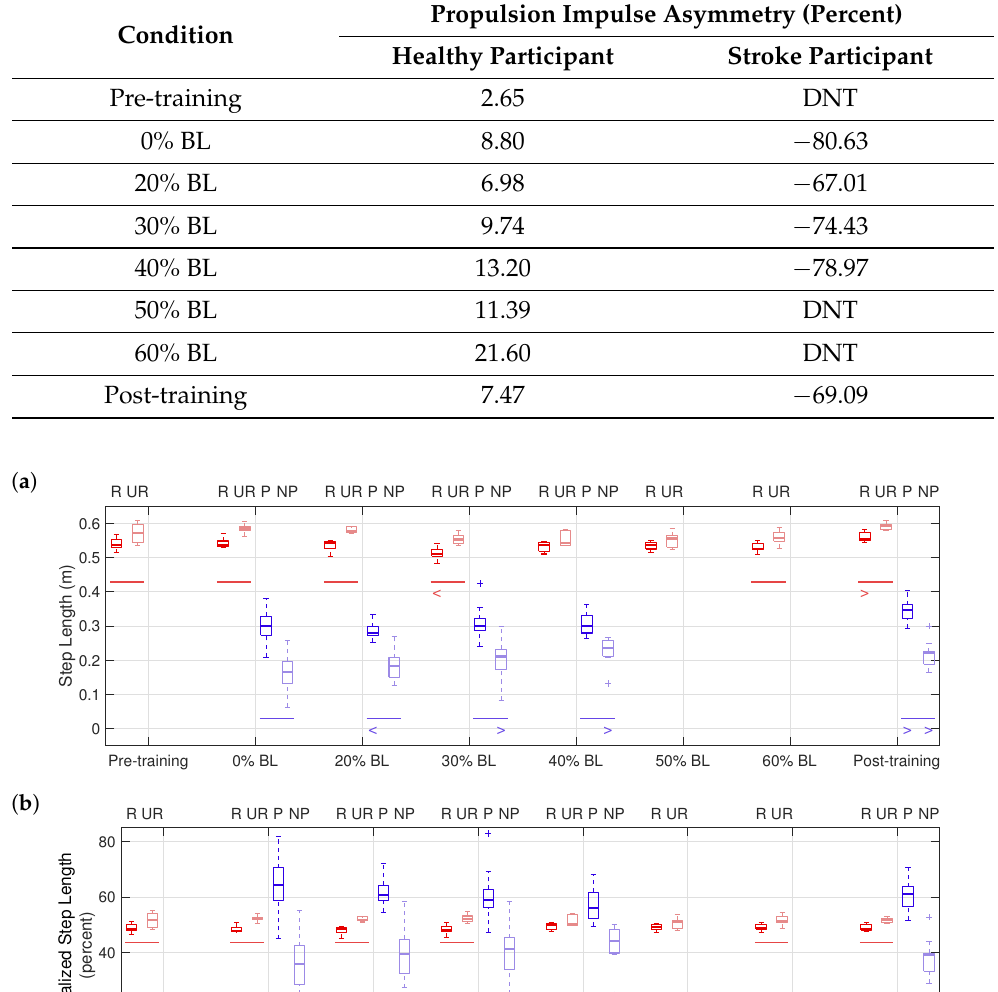
Table 5. Propulsion impulse asymmetry. A positive asymmetry means that the impulse generated by the resisted or paretic leg is higher. DNT stands for ‘Did Not Test’ for the stroke participant.